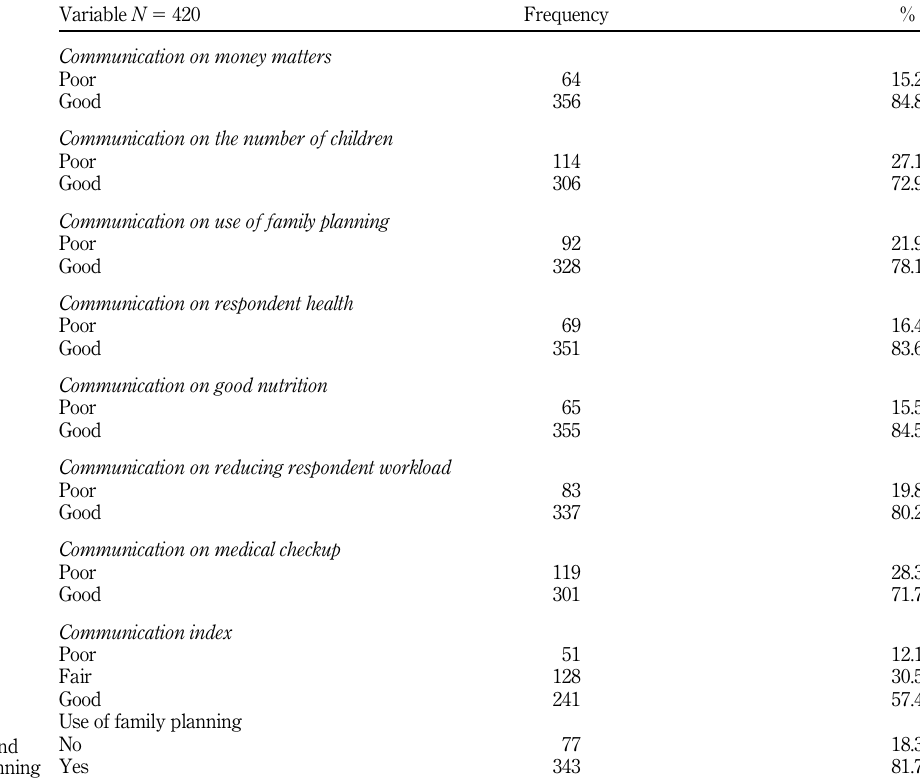
communication and use of family